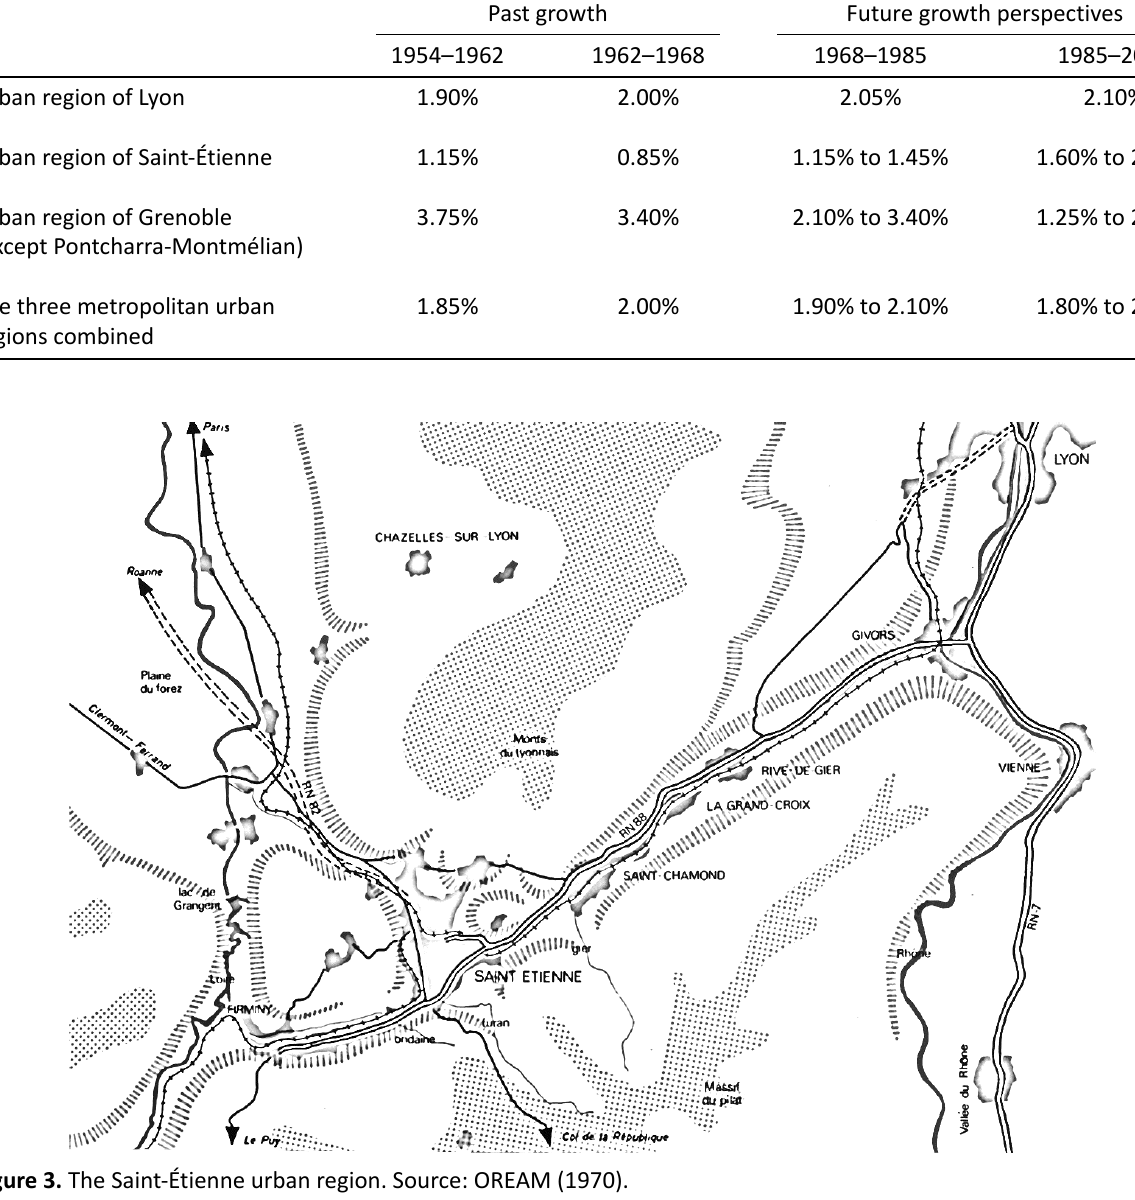
Table 1. Annual percentage of past population growth and future perspectives in the 1970 OREAM plan.